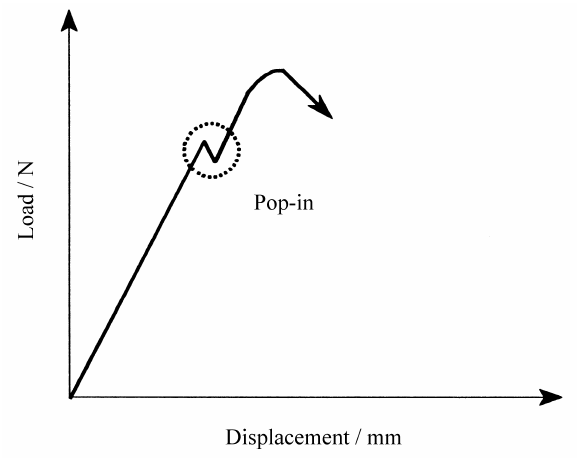
Figure 1. Typical pop-in manifestation in a P vs. CMOD record.